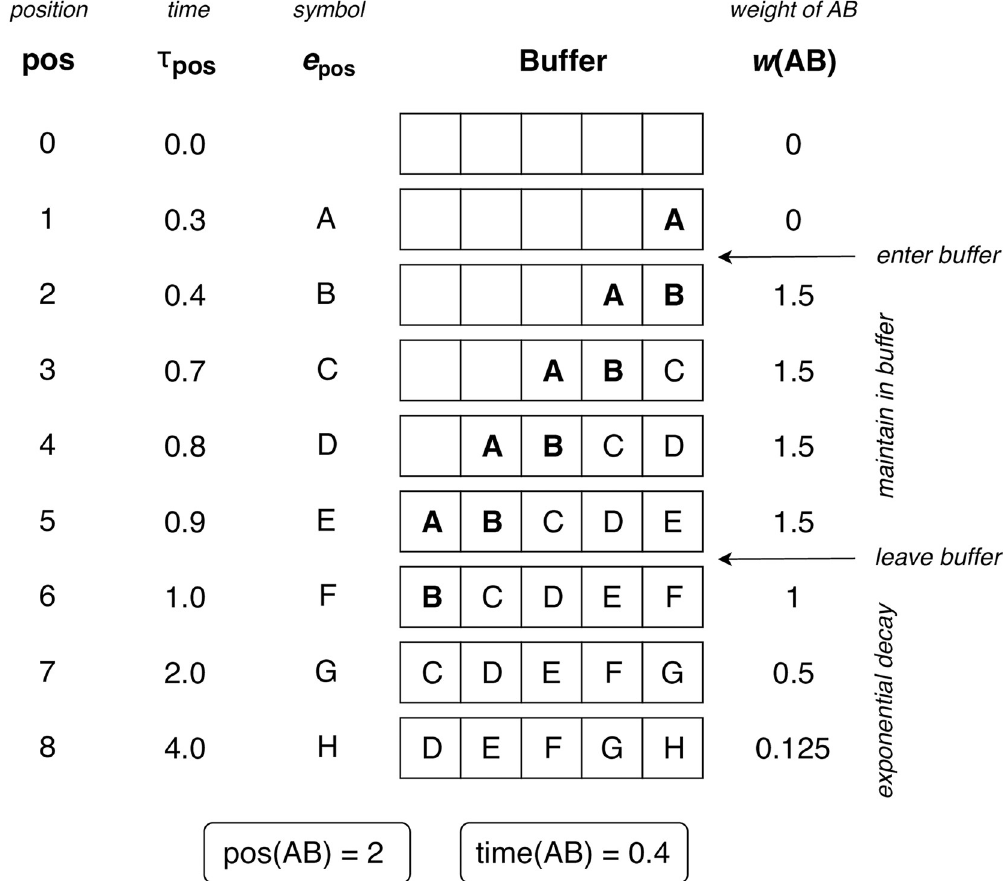
Fig 9. Schematic figure of accumulating observations within a memory buffer. Weights for the n -gram “AB” are displayed as a function of time, assuming an itemwise buffer capacity ( n b ) of 5, a buffer weight ( w 0 ) of 1.5, an initial post-buffer weight ( w 1 ) of 1, a half life ( t 0.5 ) of 1 second, and an asymptotic post-buffer weight ( w 1 ) of 0.